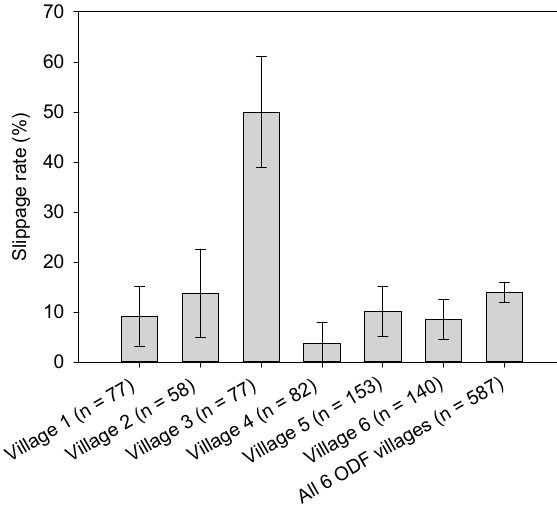
Figure 4. Slippage rates in six open defecation free (ODF) verified villages. The definition of slippage includes (1) households reporting to not always use their private latrine when at home, and households whose private latrine did not show any sign of latrine use via observation, (2) households reporting to not always use a shared latrine when at home, and (3) households reporting to practice open defecation usually. Error bars represent 95% confidence intervals.